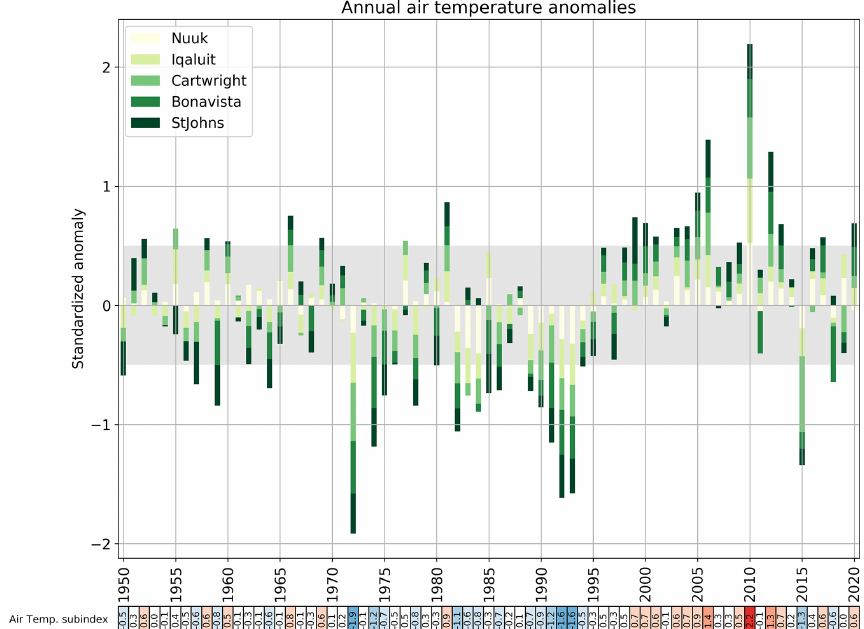
Figure A1. Same as Fig. 3 but using a climatology referenced to the 1981–2010